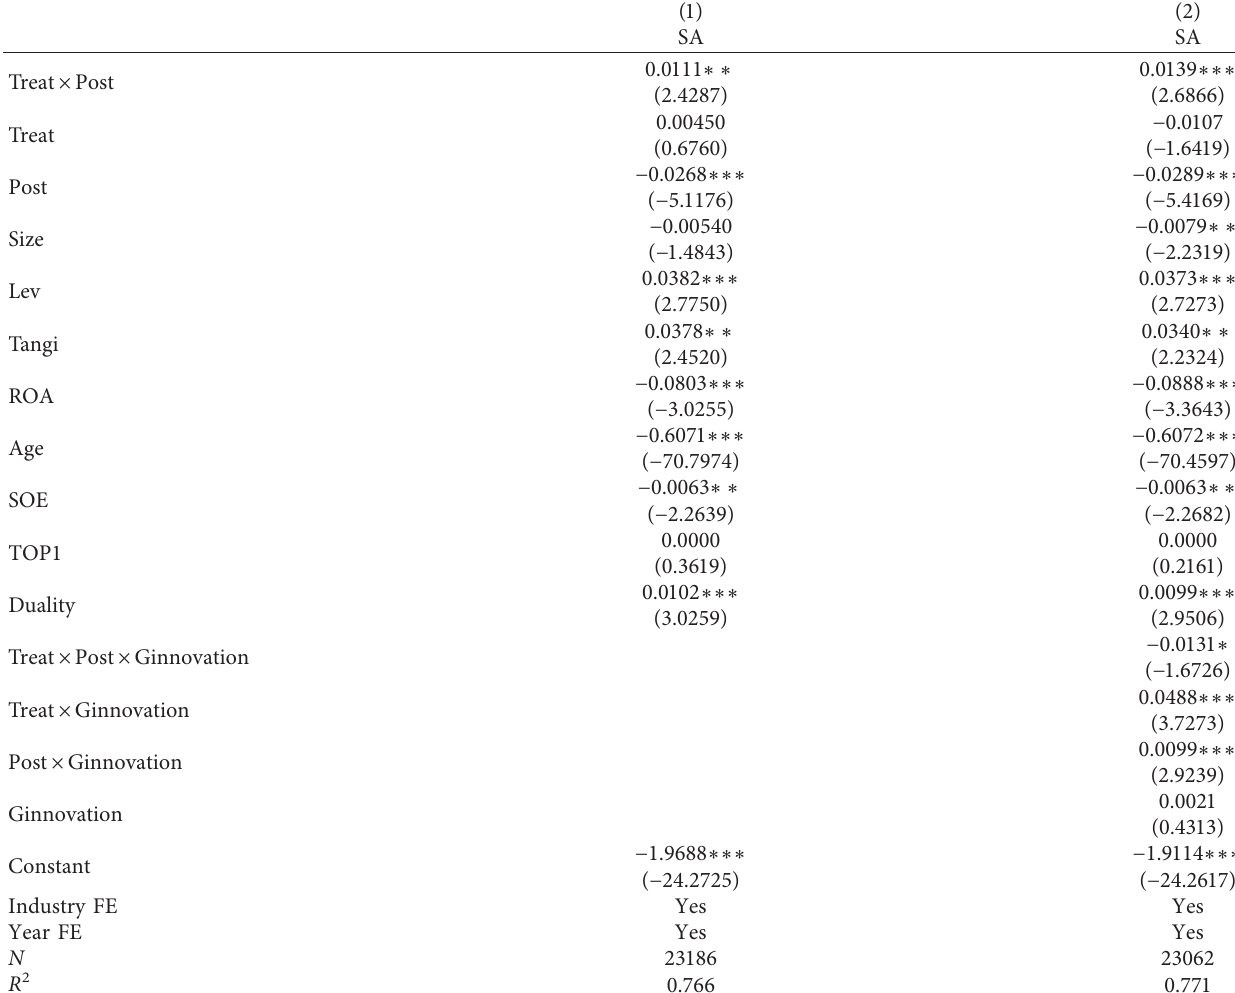
Table 5: Economic mechanism